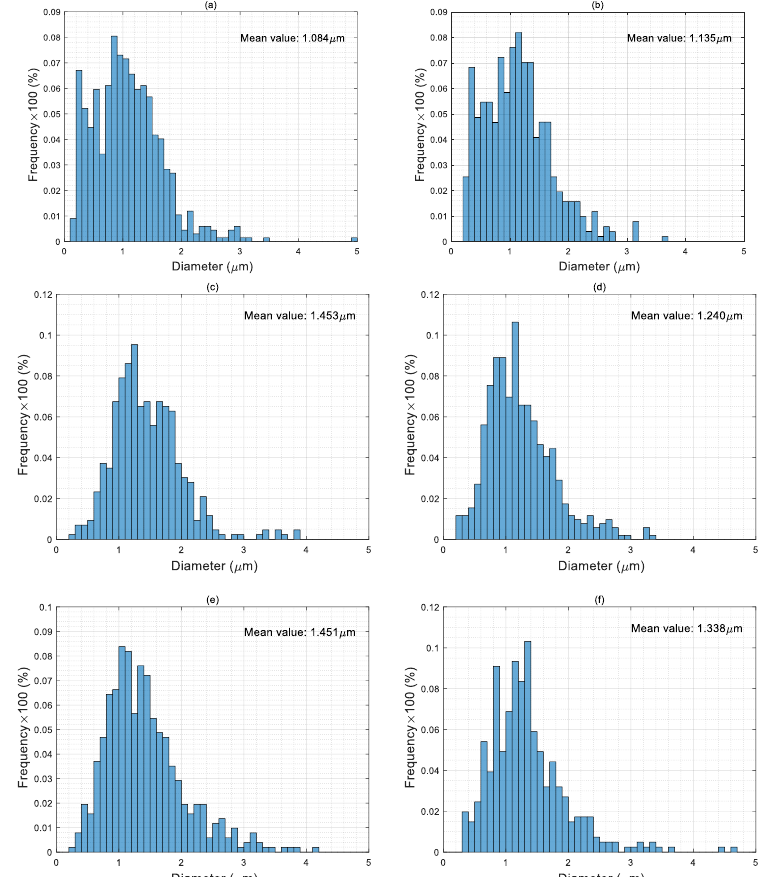
Figure 5. Particle size distributions of the electro-sprayed materials ( a ) sample T; ( b ) sample T/C; ( c ) sample T/AG; ( d ) sample T/AP; ( e ) sample T/C/AG; and ( f ) sample T/C/AP. ( c ) sample T / AG; ( d ) sample T / AP; ( e ) sample T / C / AG; and ( f ) sample T / C /